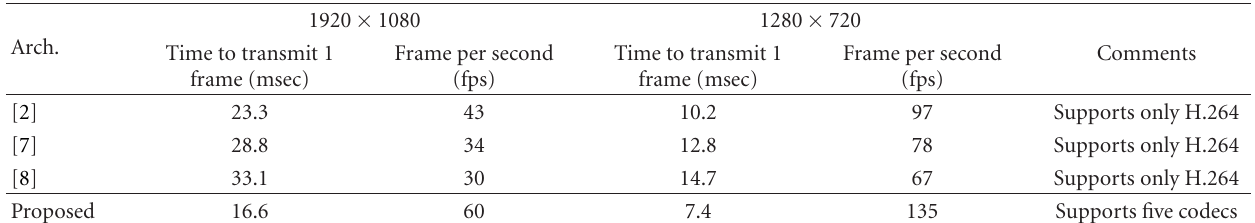
Table 6: Comparison of decoding capability of the multiquantizer schemes.